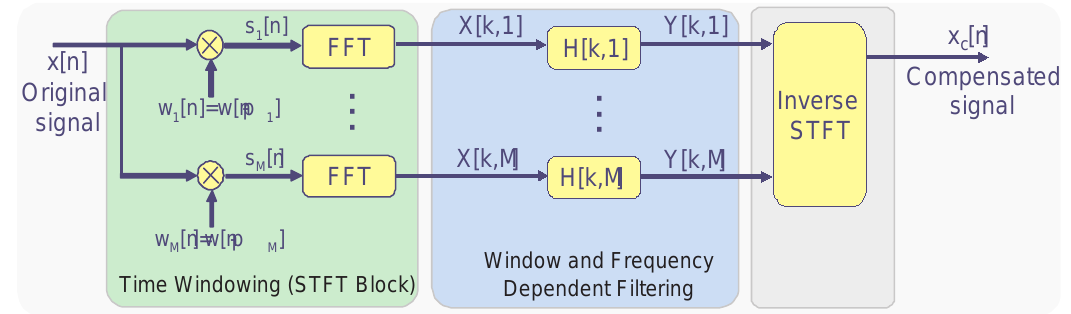
Figure 13. The block diagram of the dispersion compensation method.